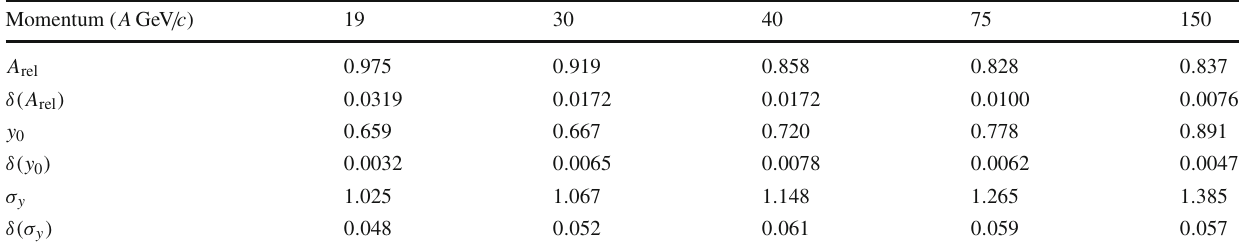
Table 4 Fitted parameters A rel , y 0 of the double Gaussian fit and RMS width σ y of the rapidity distribution calculated from Eq. 6 Momentum ( A GeV / c